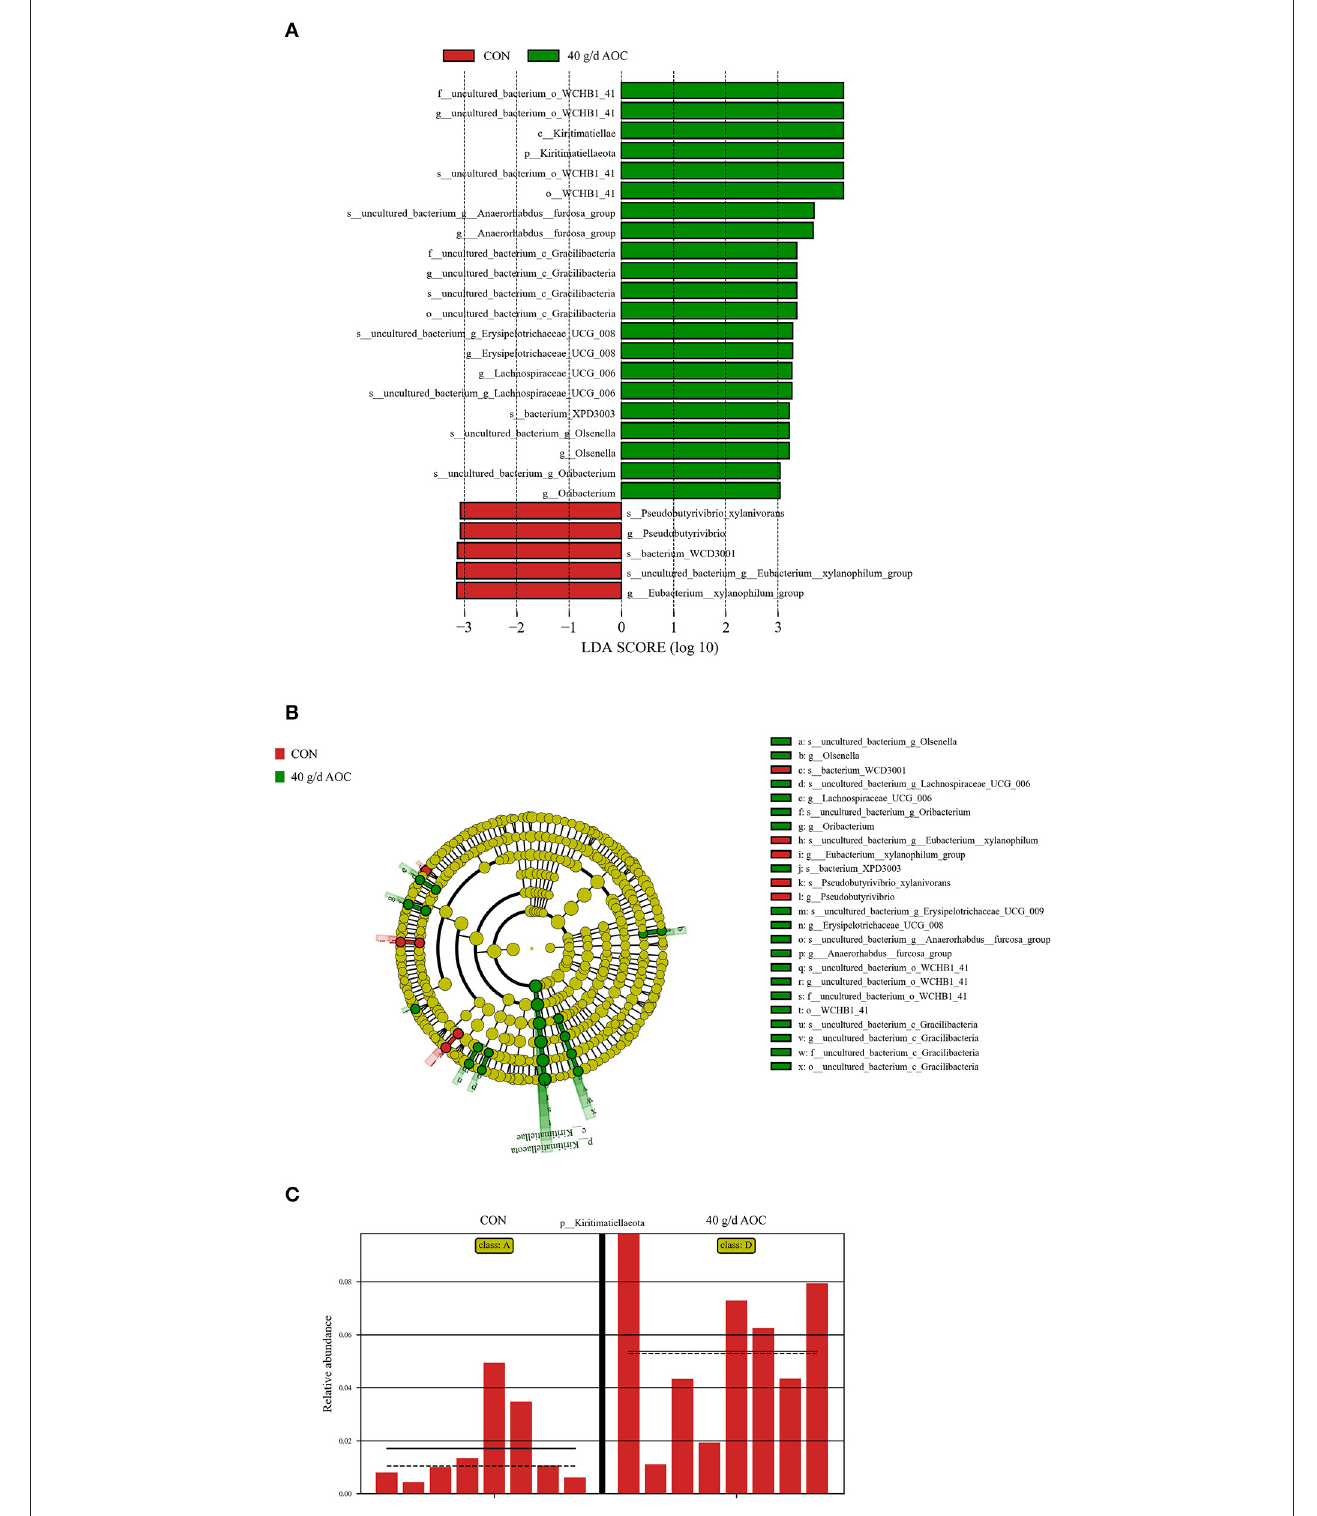
FIGURE 2 | Histogram of the line discriminant analysis (LDA) effect size (A) , cladogram (B) , and relative abundance of Kiritimatiellae (C) in the 40 g/d AOC group compared with CON. Only the genera with a linear discriminant analysis significant threshold > 2 are shown.